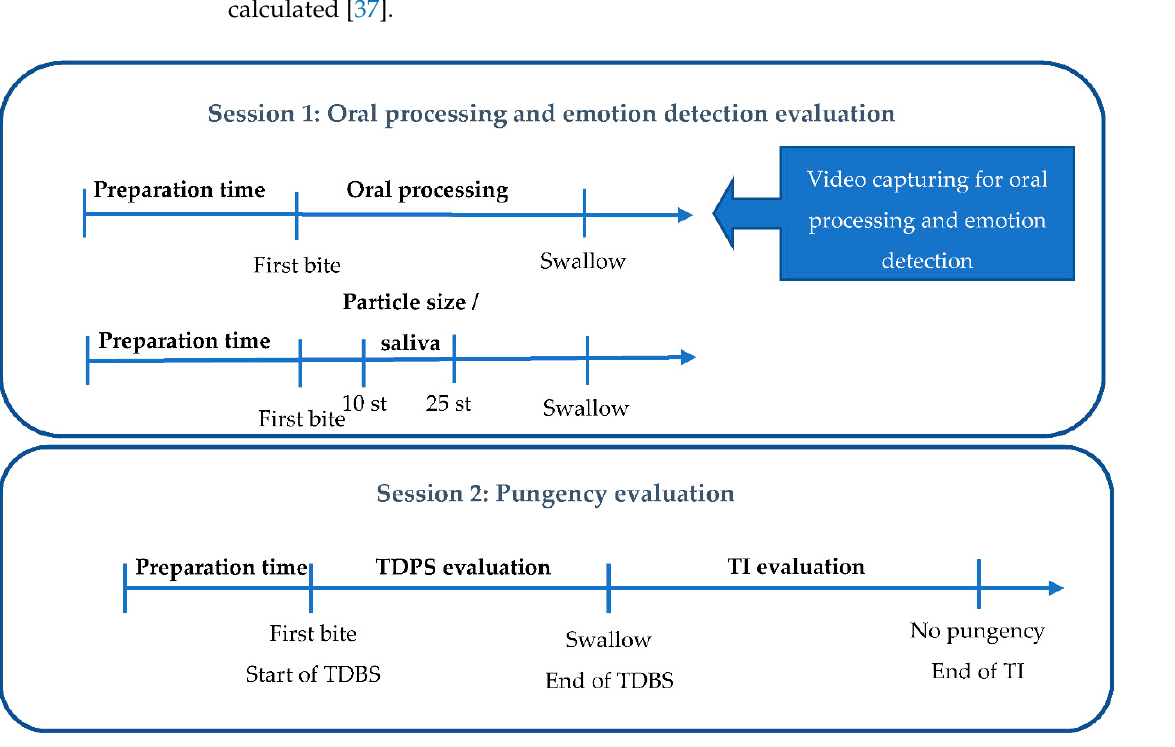
Figure 1. Schematic overview of the research protocol with an indication of specific method employed. Legend: TDPS— temporal dominance pungency sensation; TI—time-intensity measurement; st—stroke.